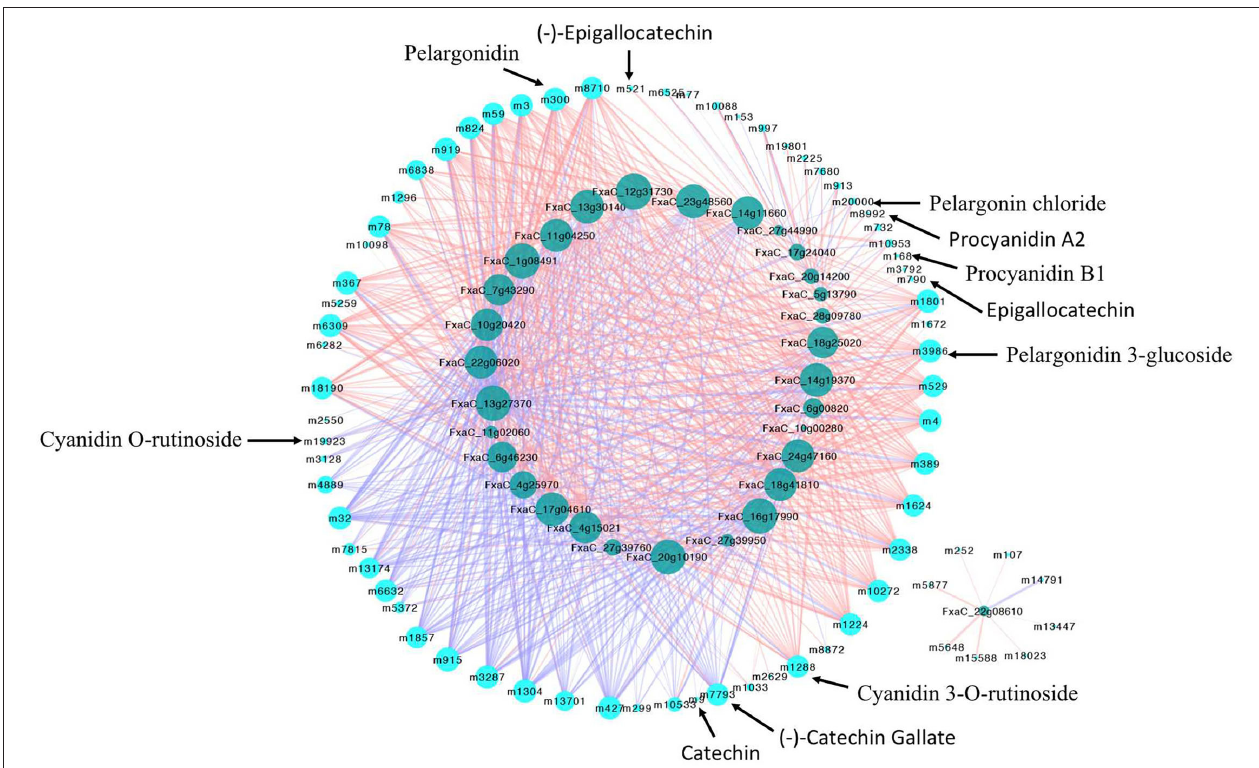
FIGURE 9 | Network showing the correlation between up-regulated TFs and metabolites during the fruit development and ripening of mutant. Genes-metabolites correlation pairs with p < 0.05 were showed. The light and dark blue nodes represented metabolites and TFs, respectively. Blue and pink lines represented negative and positive correlation,